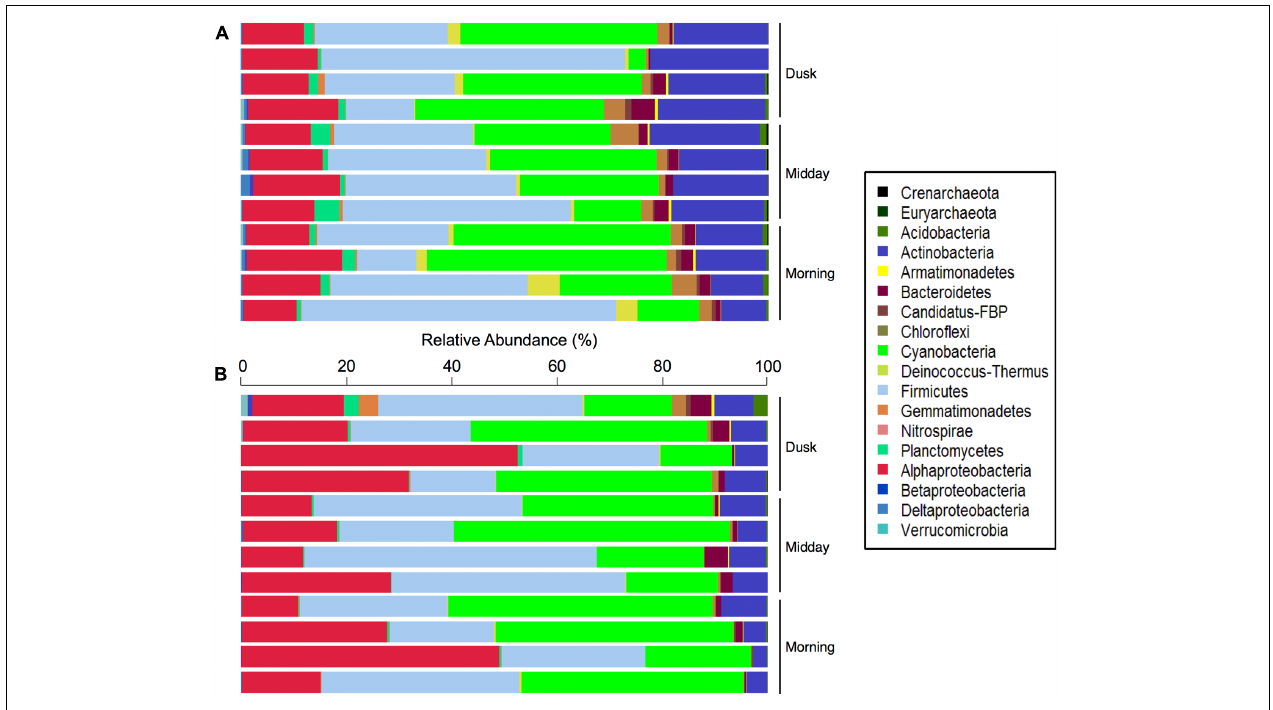
FIGURE 2 | Relative abundances (%) of bacterial and archaeal phyla in the (A) total and (B) potentially active Namib hypolithic